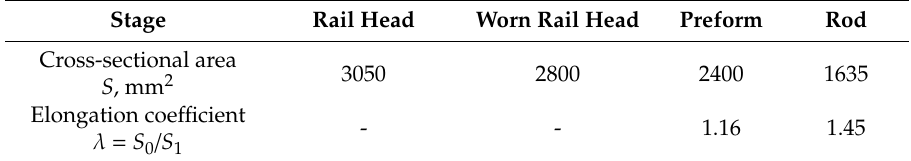
Table 1. Geometric parameters and elongation coe ffi cients for the successive stages of the rolling process.